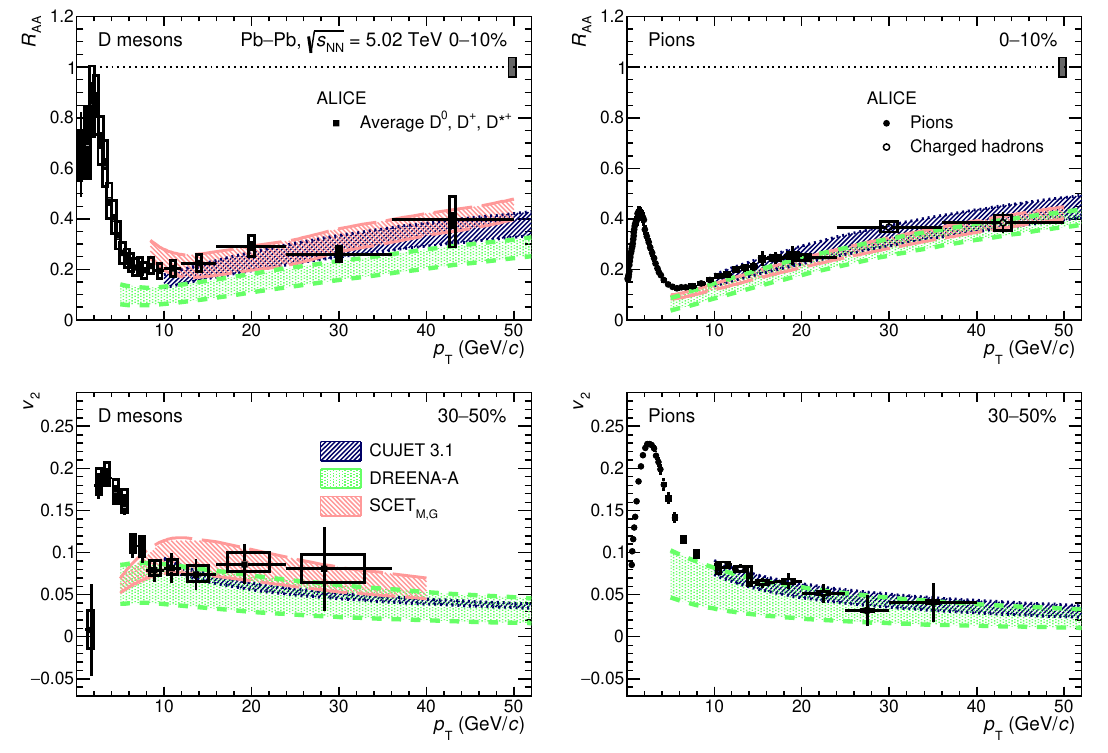
Figure 10 . Average R AA (top panels) and v 2 (bottom panels) of prompt D 0 , D + , and D ∗ + mesons [36] and pions (charged hadrons) [84, 85, 88] compared with predictions from models